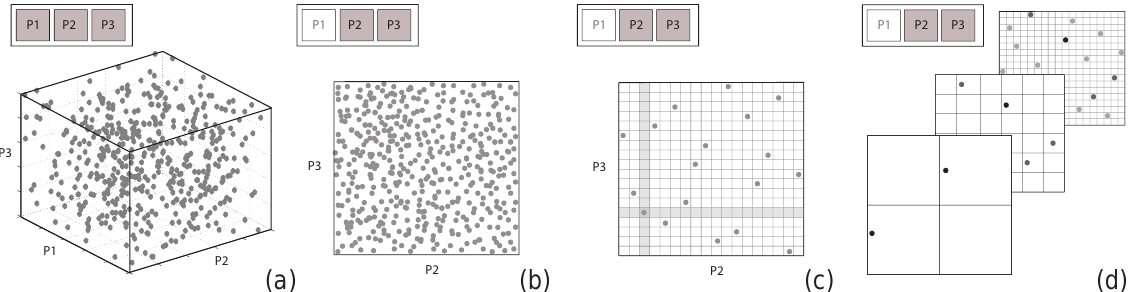
Figure 5. Parameter sampling as applied in this study. (a) Example situation when sampling for a model with three parameters. (b) Sen- sitivity analysis can be conducted to decrease the dimensions of the sampling space. (c) Latin Hypercube sampling is structured and more efficient: one sample in each row and each column, as indicated with the bands. The number of samples has to be determined